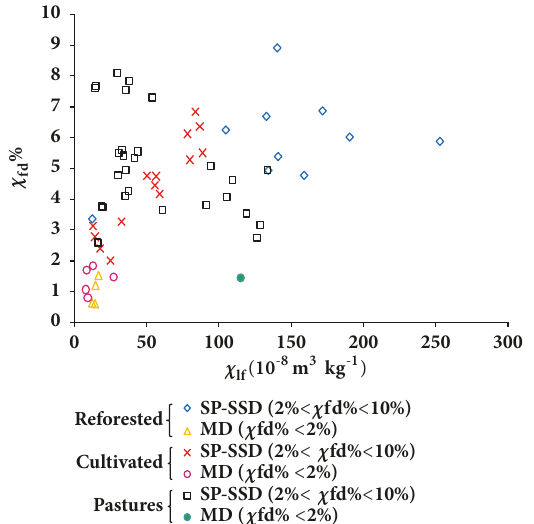
Figure 7: Bivariate diagram 𝜒 lf - 𝜒 fd % showing a distribution of magnetic grain sizes in the soils from the reforested soil, cultivated, and pastures